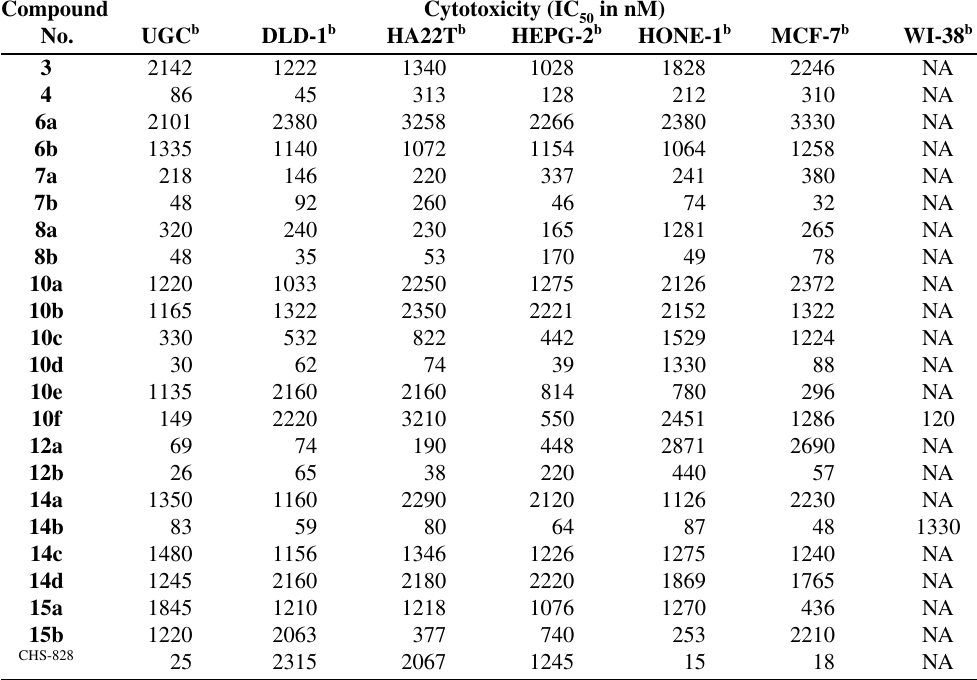
Compound Cytotoxicity (IC